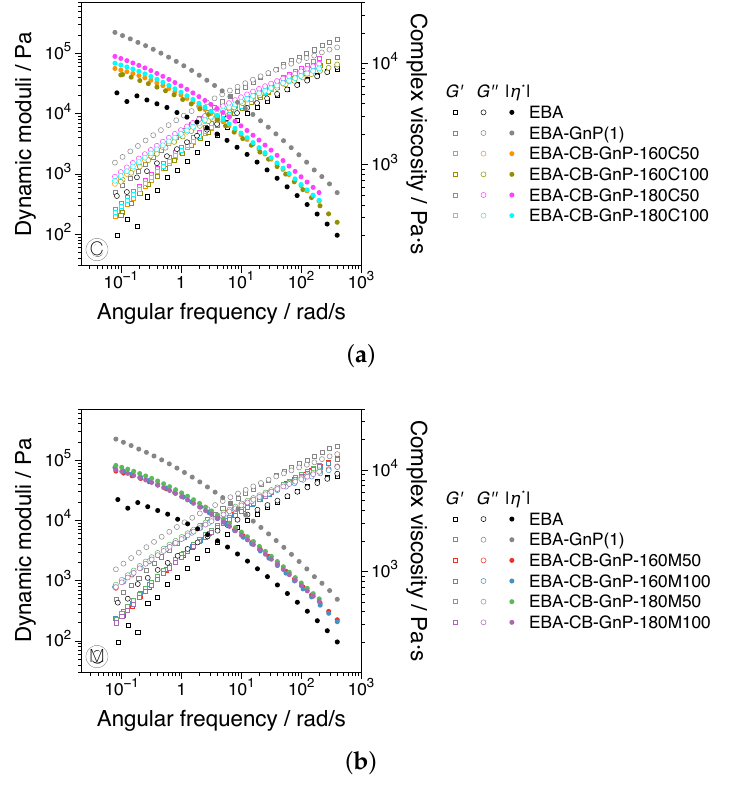
Figure 5. Dynamic frequency sweep measurements in the linear viscoelastic regime of the samples investigated, prepared using ( a ) the conventional screw, C, and ( b ) the distributive mixing screw, M. In both diagrams, the EBA matrix and EBA-GnP are plotted as references.